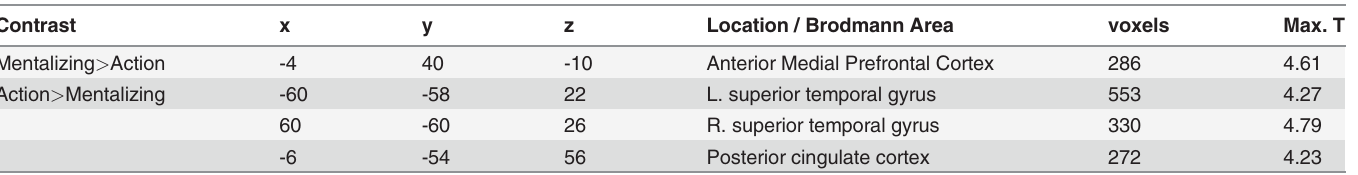
Table 5. Results of whole-brain